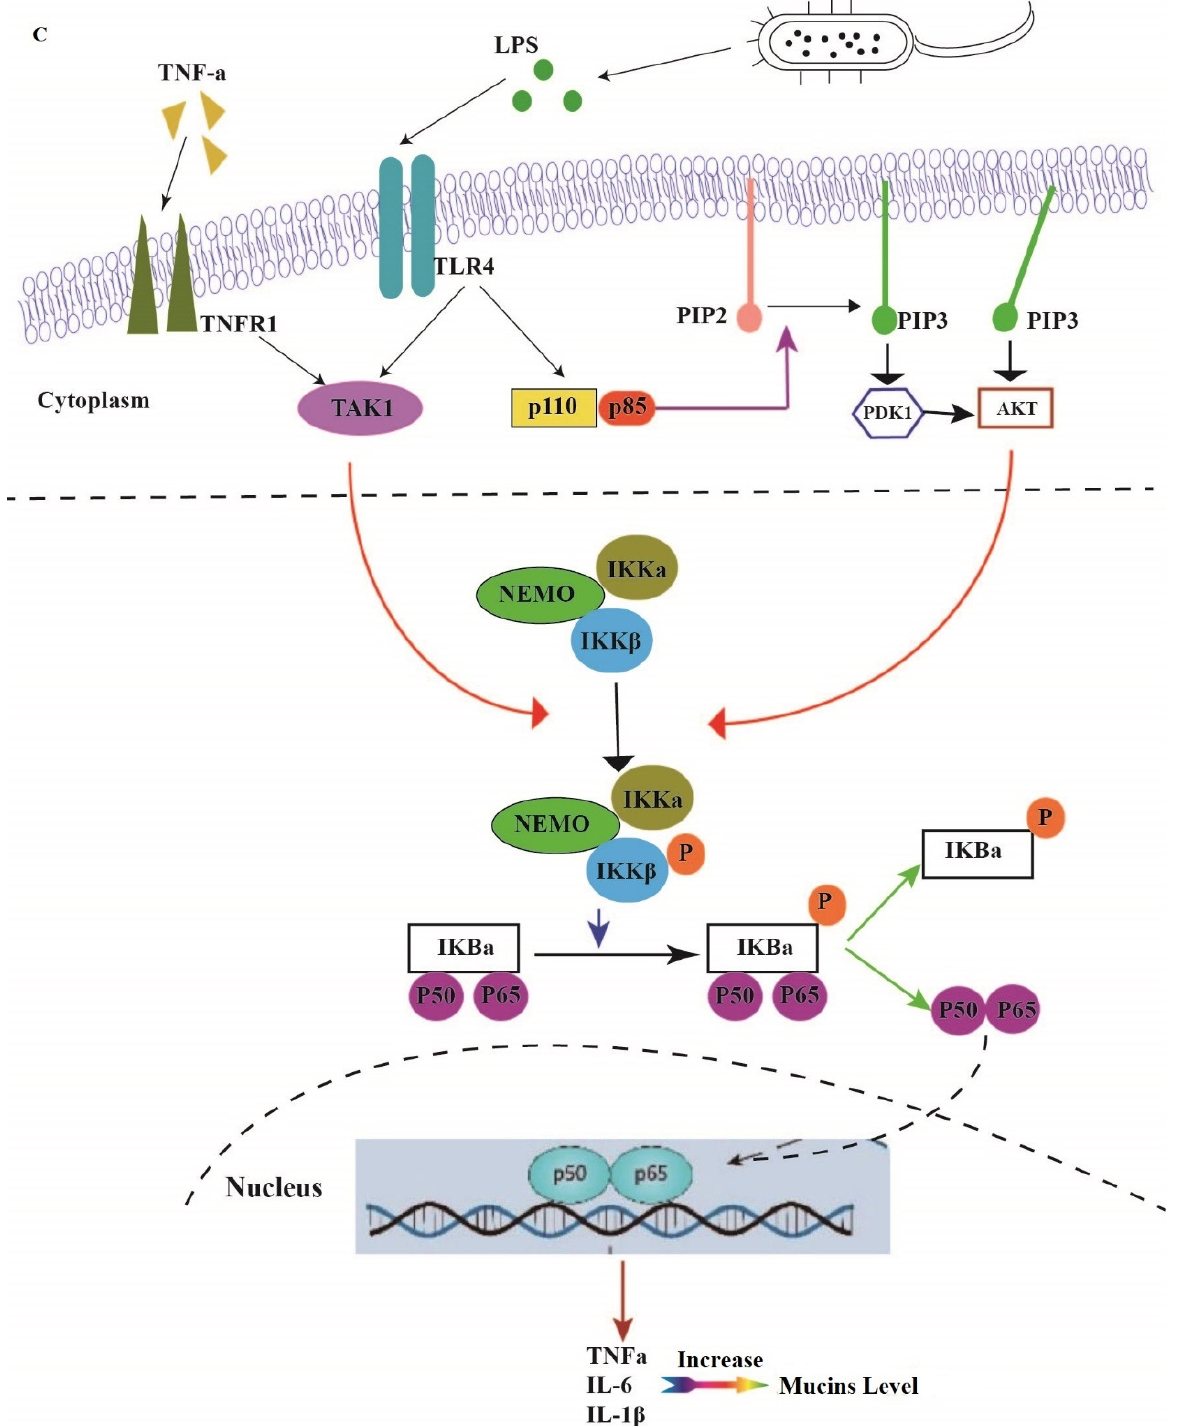
Figure 6. Effect of LPS on PI3K/AKT/NF- κ B signaling pathway during pregnancy. At day 7 of pregnancy. Effect of LPS on factors influencing mRNA expression of PI3K/AKT/NF- κ B signaling pathway in uteri of mice ( A ); Effect LPS on factors influencing mRNA expression of PI3K/AKT/NF- κ B signaling pathway in uteri of mice at day 15 of pregnancy ( B ); Mechanism of LPS effect on PI3K/AKT/NF- κ B signaling pathway in uteri of mice during pregnancy ( C ). * Statistical difference between LPS (+) and LPS (-) groups in the same period ( p < 0.05); ** statistical difference between LPS (+) and LPS (-) groups in the same period ( p <